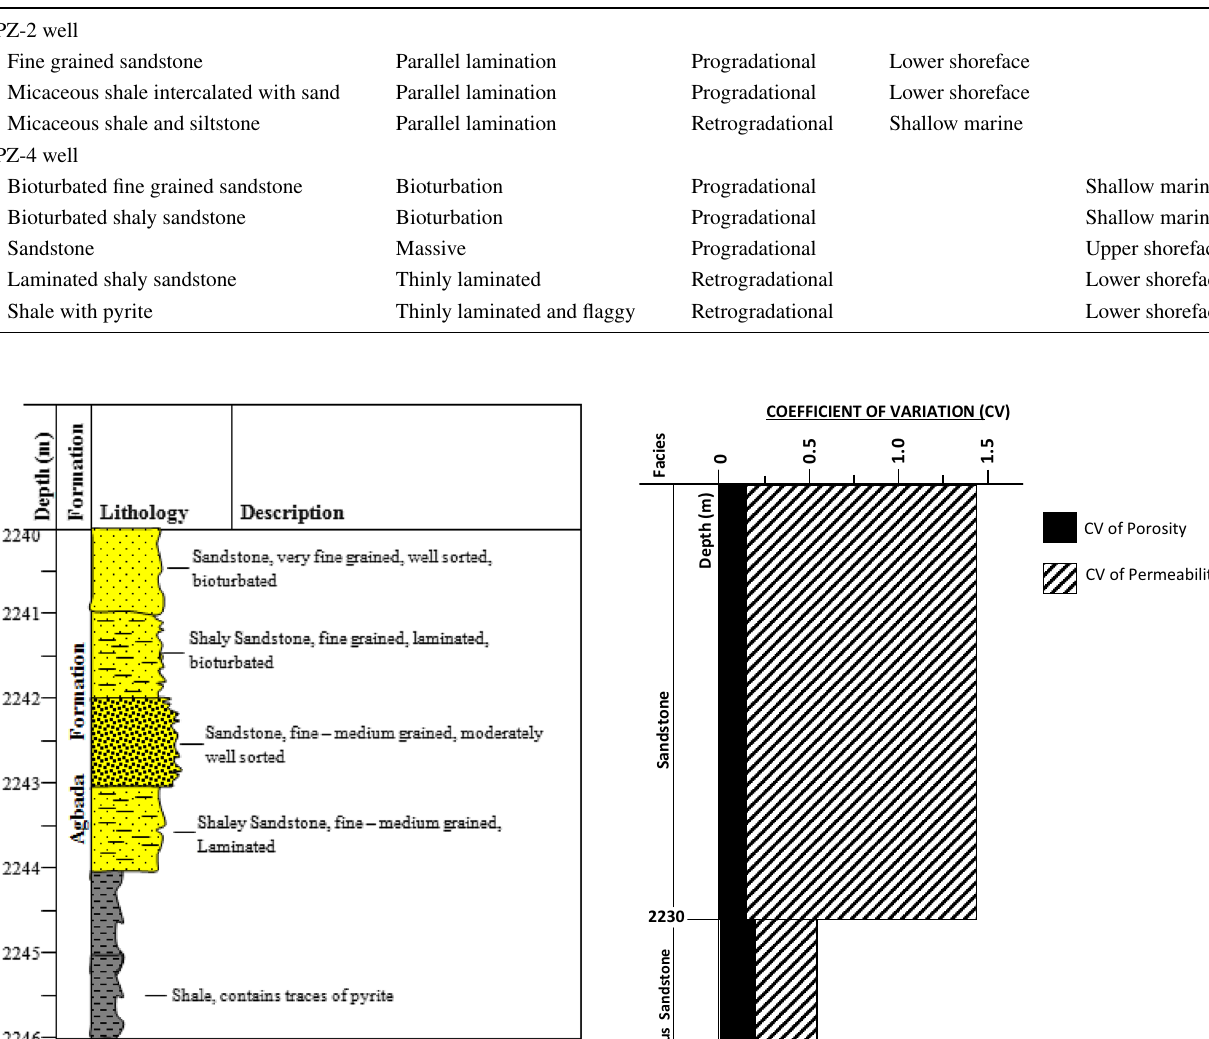
Table 3 Lithofacies characterization of sediments in PZ-2 and PZ-4 wells Facies